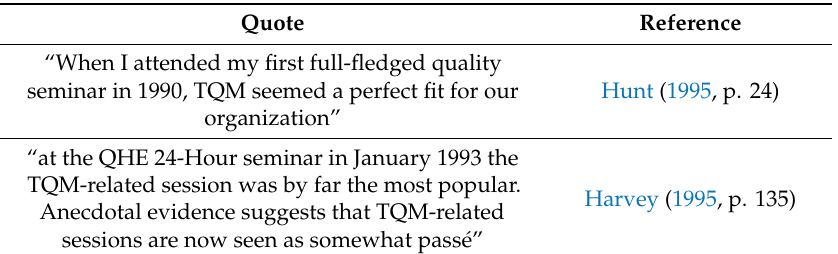
Table 2. Illustrative quotes about the role of conferences / seminars related to